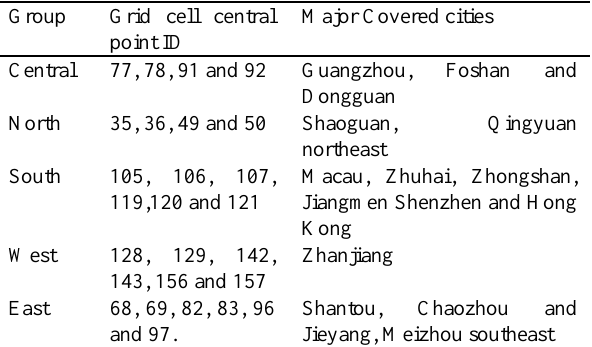
Table1. Compare groups of AOD cell central points